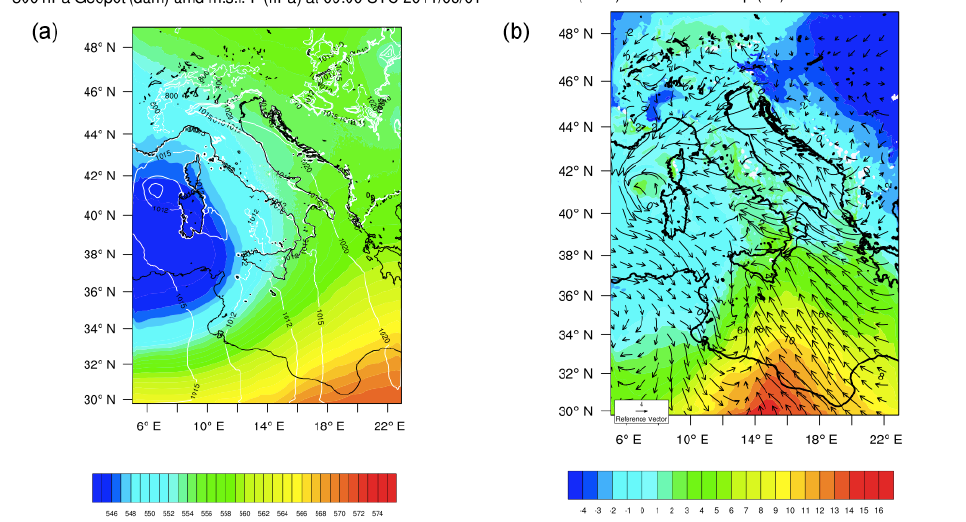
Figure 6. Mesoscale maps during the weather storm on 1 March 2011 (Event 1). (a) WRF (domain 1) geopotential height (in decameter; colours) at 500hPa and mean sea level pressure (in hPa, white lines). (b) WRF (domain 1) 850hPa temperature (in C, colours) and 10m wind (in ms − 1 , black